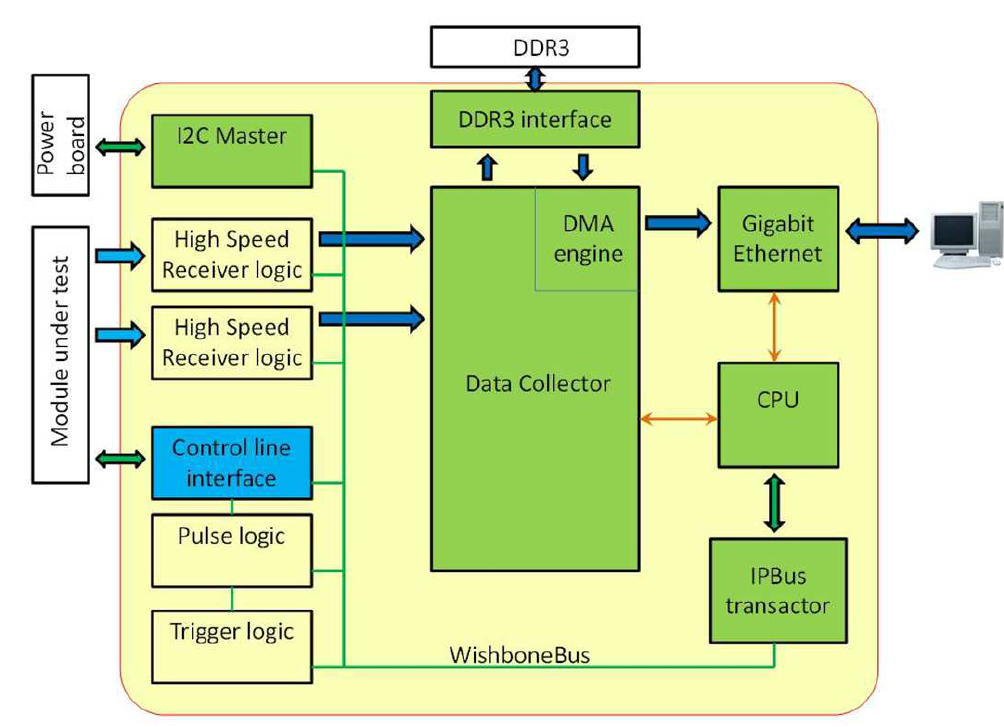
Figure 2. Block diagram of the FPGA firmware for the test of the ALICE new tracker modules